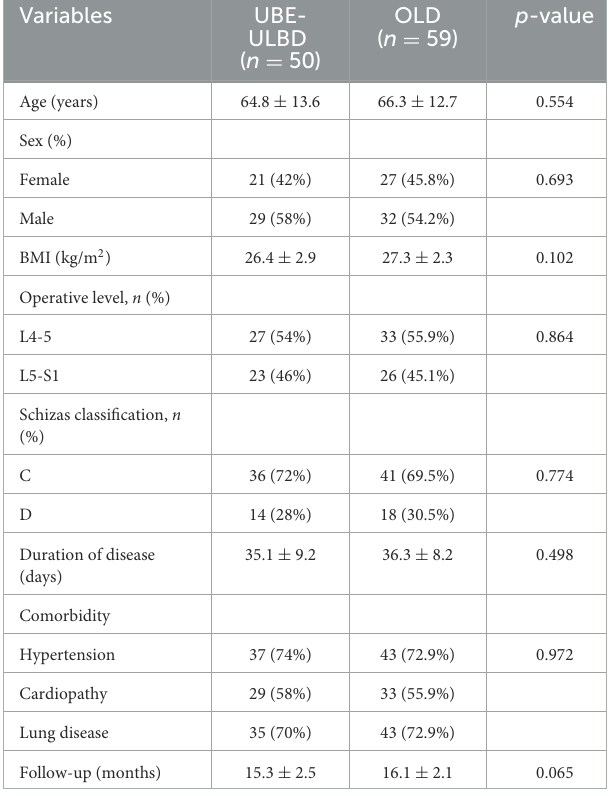
TABLE 1 Patient demographic